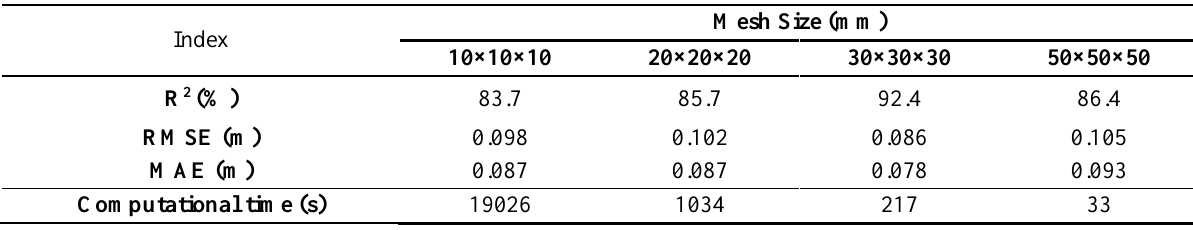
Mesh sizes assessment.